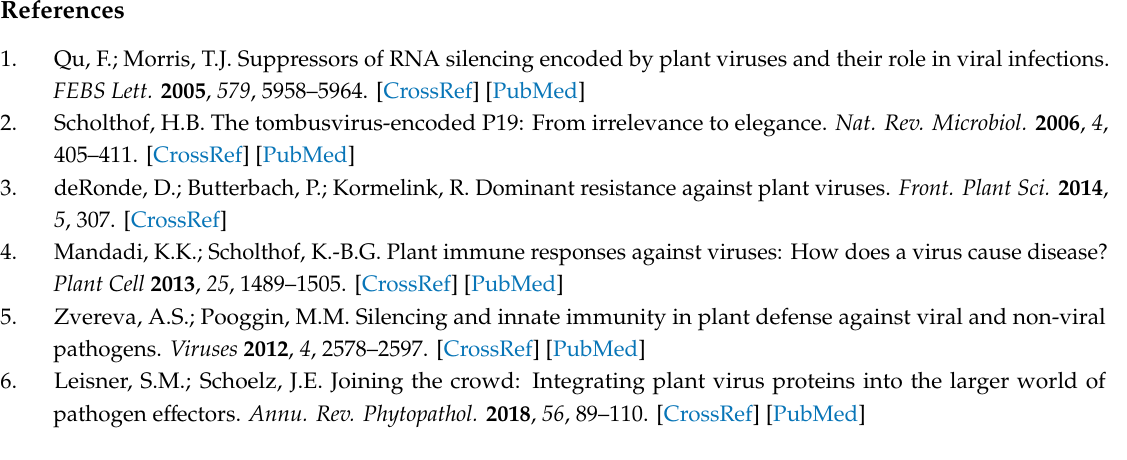
Figure S1: Response of Nicotiana species to TNVD H virion inoculation. Figure S2: Response of Nicotiana species to TNVD H virion inoculation. Figure S3: Response of Nicotiana species to TNVD H virion inoculation. Figure S4: Response of Nicotiana species to TNVD H virion inoculation. Figure S5: Evaluation of selected tombusvirid CPs for elicitation of necrosis in N. langsdor ffi i . Figure S6: Agroinfiltration of p35S-GFP alone or co-agroinfiltration